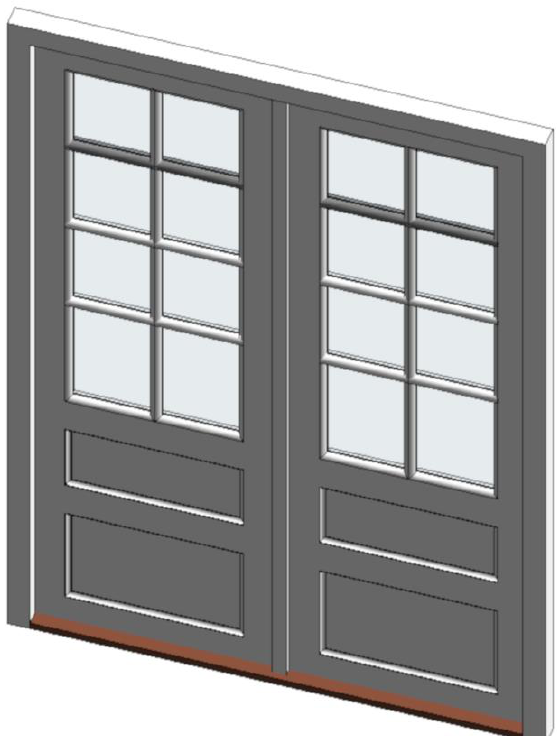
Figure 9. Example of the HBIM component – double-winged glass